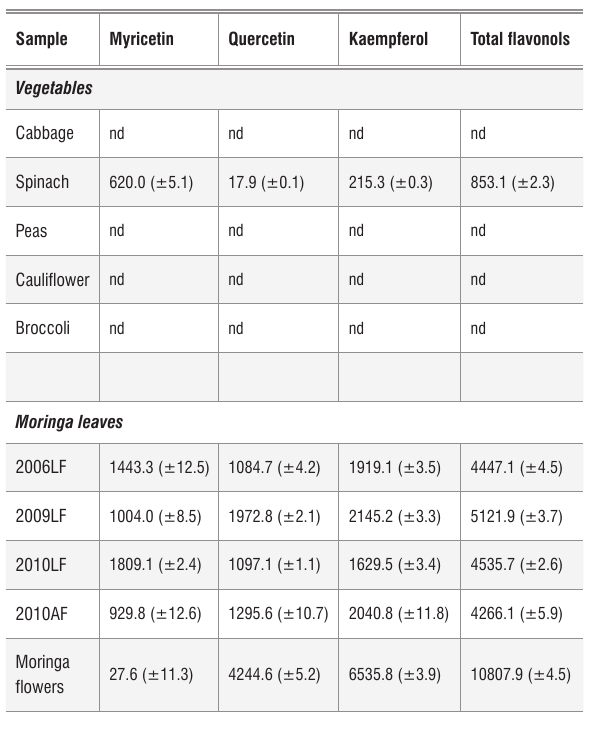
Figure 2: Typical calibration curves for flavonols.